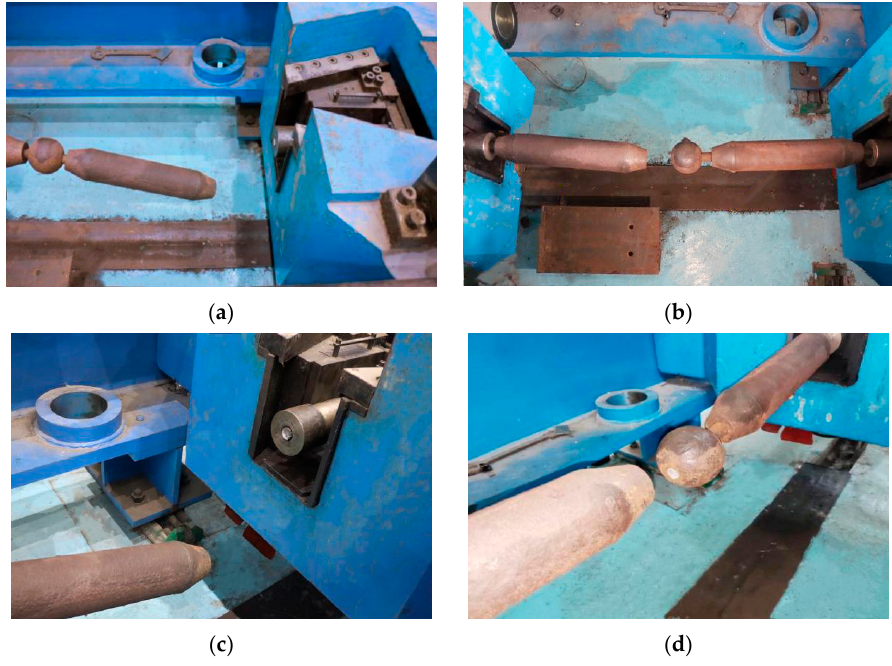
Figure 9. Fractures of individual specimens: ( a ) J-0; ( b ) J-1; ( c ) J-2; ( d ) J-3.